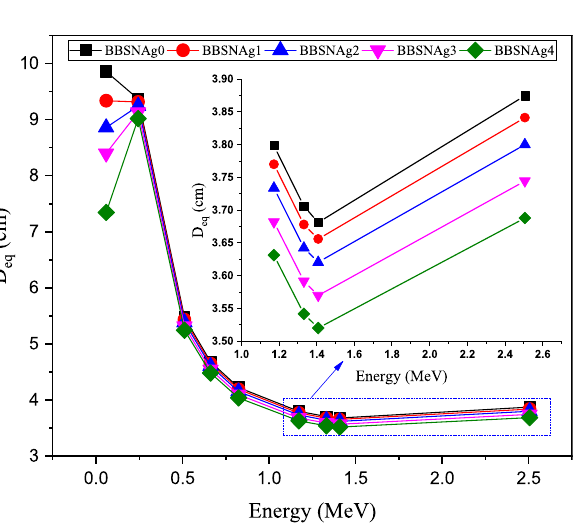
Figure 13. Variation of the D eq (cm) of the fabricated glasses at various gamma-ray